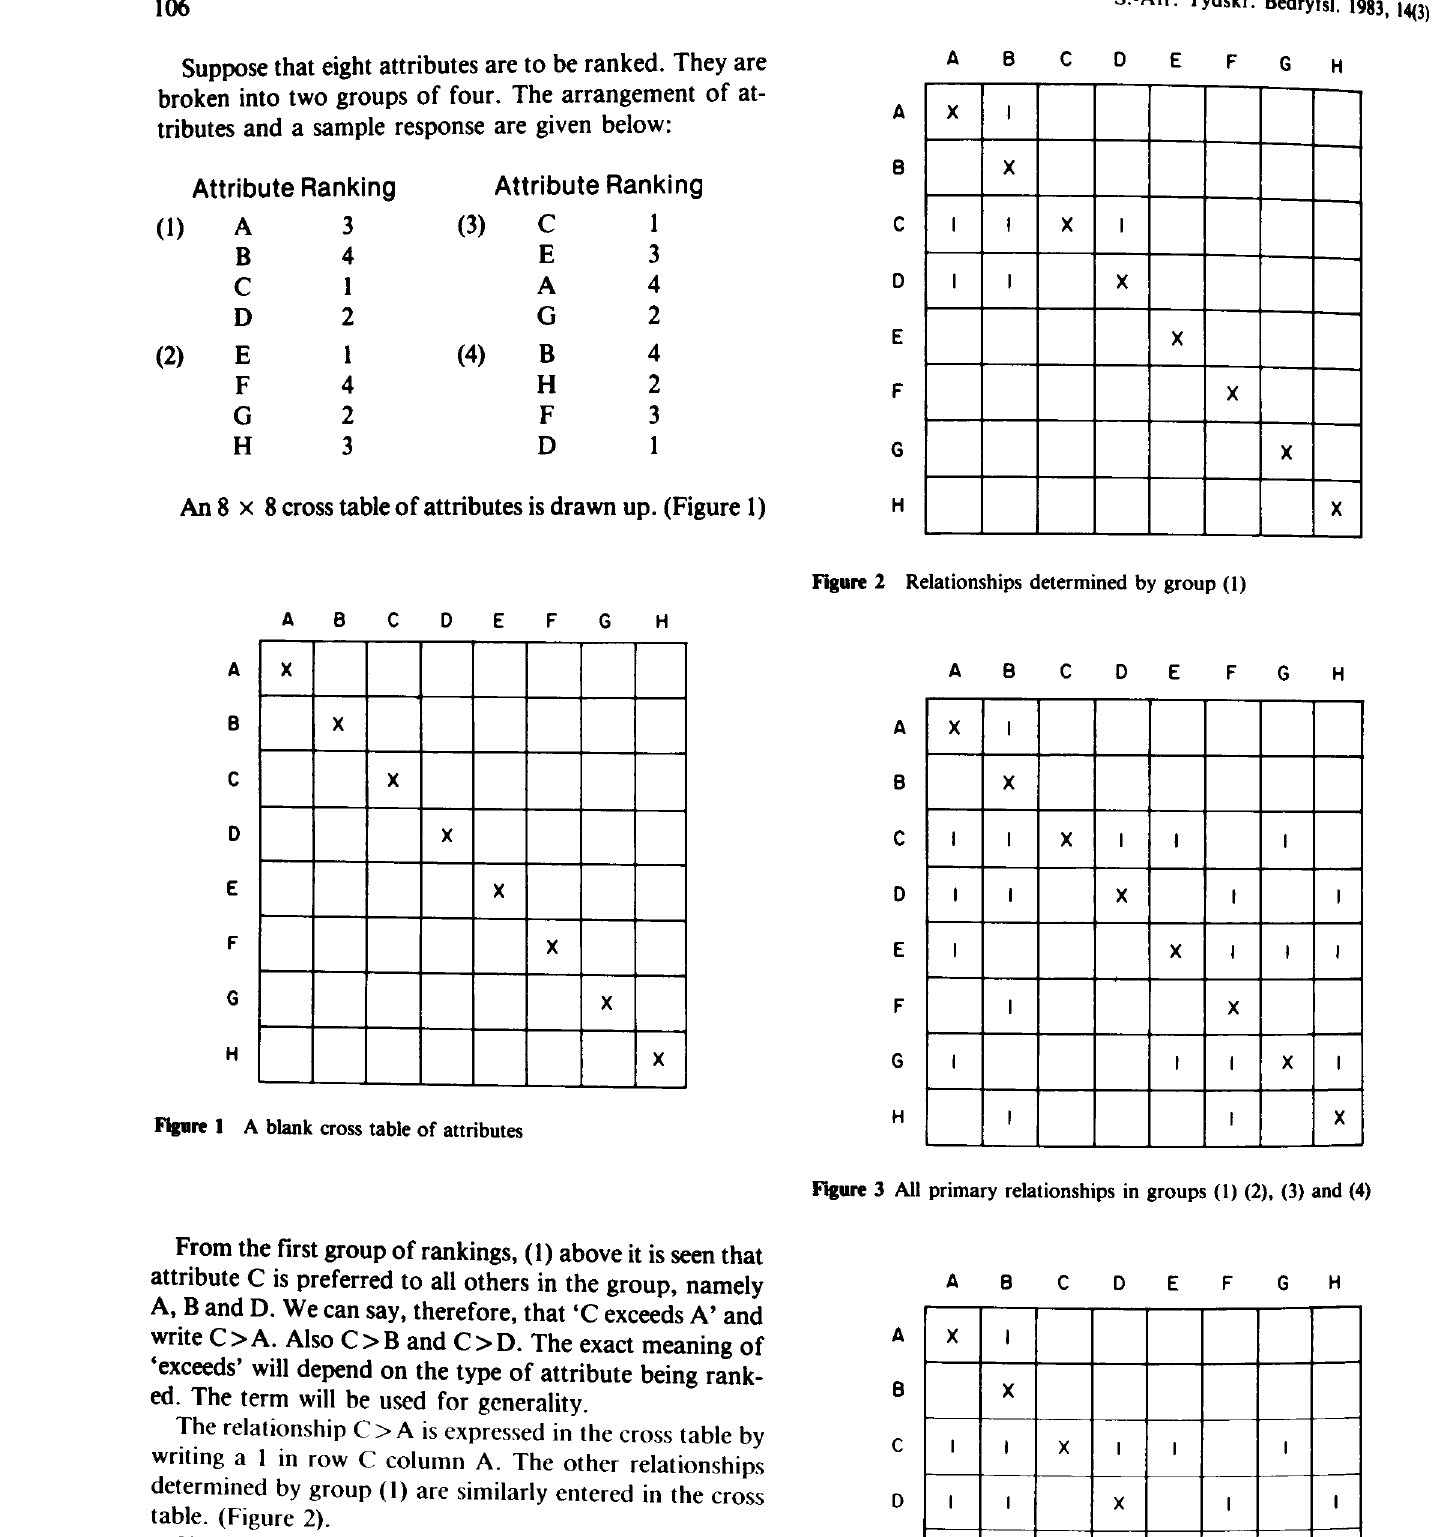
Figure 3 All primary relationships in groups (I) (2), (3) and (4)